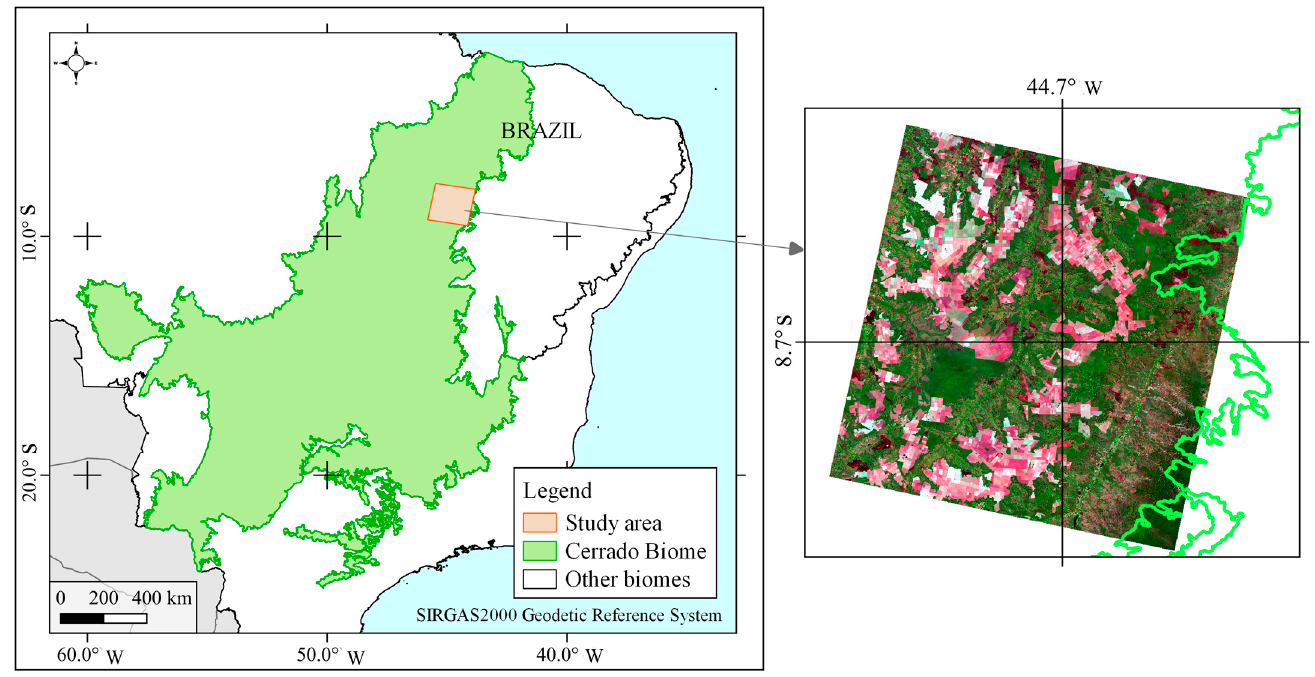
Figure 1. Location of the study area in the south of the state of Piauí and in the north of the Cerrado biome (Brazil) (coordinates in WGS84 — EPGS:4326).